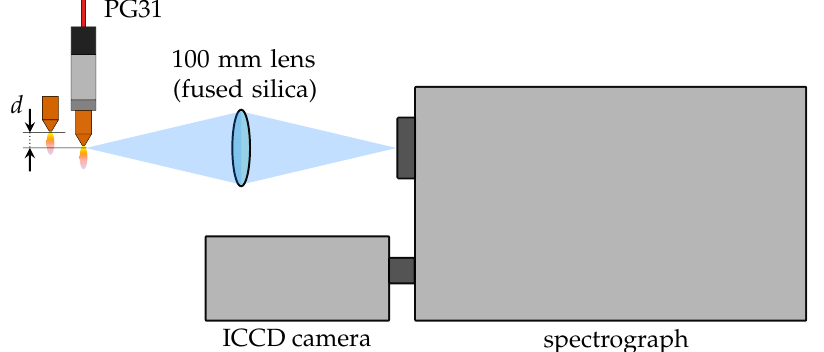
Figure 3. Schematic diagram of the spectroscopic experimental setup. The plasma generator PG31 is positioned perpendicular to the vertically oriented entrance slit of the spectrograph on a micrometer table that allows the axial distance d from the nozzle outlet to be varied. The instrumental profile is estimated by homogeneous illumination of the 100 µm wide entrance slit with a krypton spectral calibration lamp of type 6031 produced by Oriel Instruments, Stratford, CT, USA. For the spectral line at λ 0 = 450.24 nm, the resulting instrumental function depicted in Figure 4 has a full width at half maximum (short FWHM) of 0.1 nm. The spatial resolution is determined to be 0.07 mm/px. Additionally, an absolute calibration of the entire experimental setup is performed using a spectral radiance calibration standard, which is a frosted 50 W quartz-halogen lamp in an integrating sphere